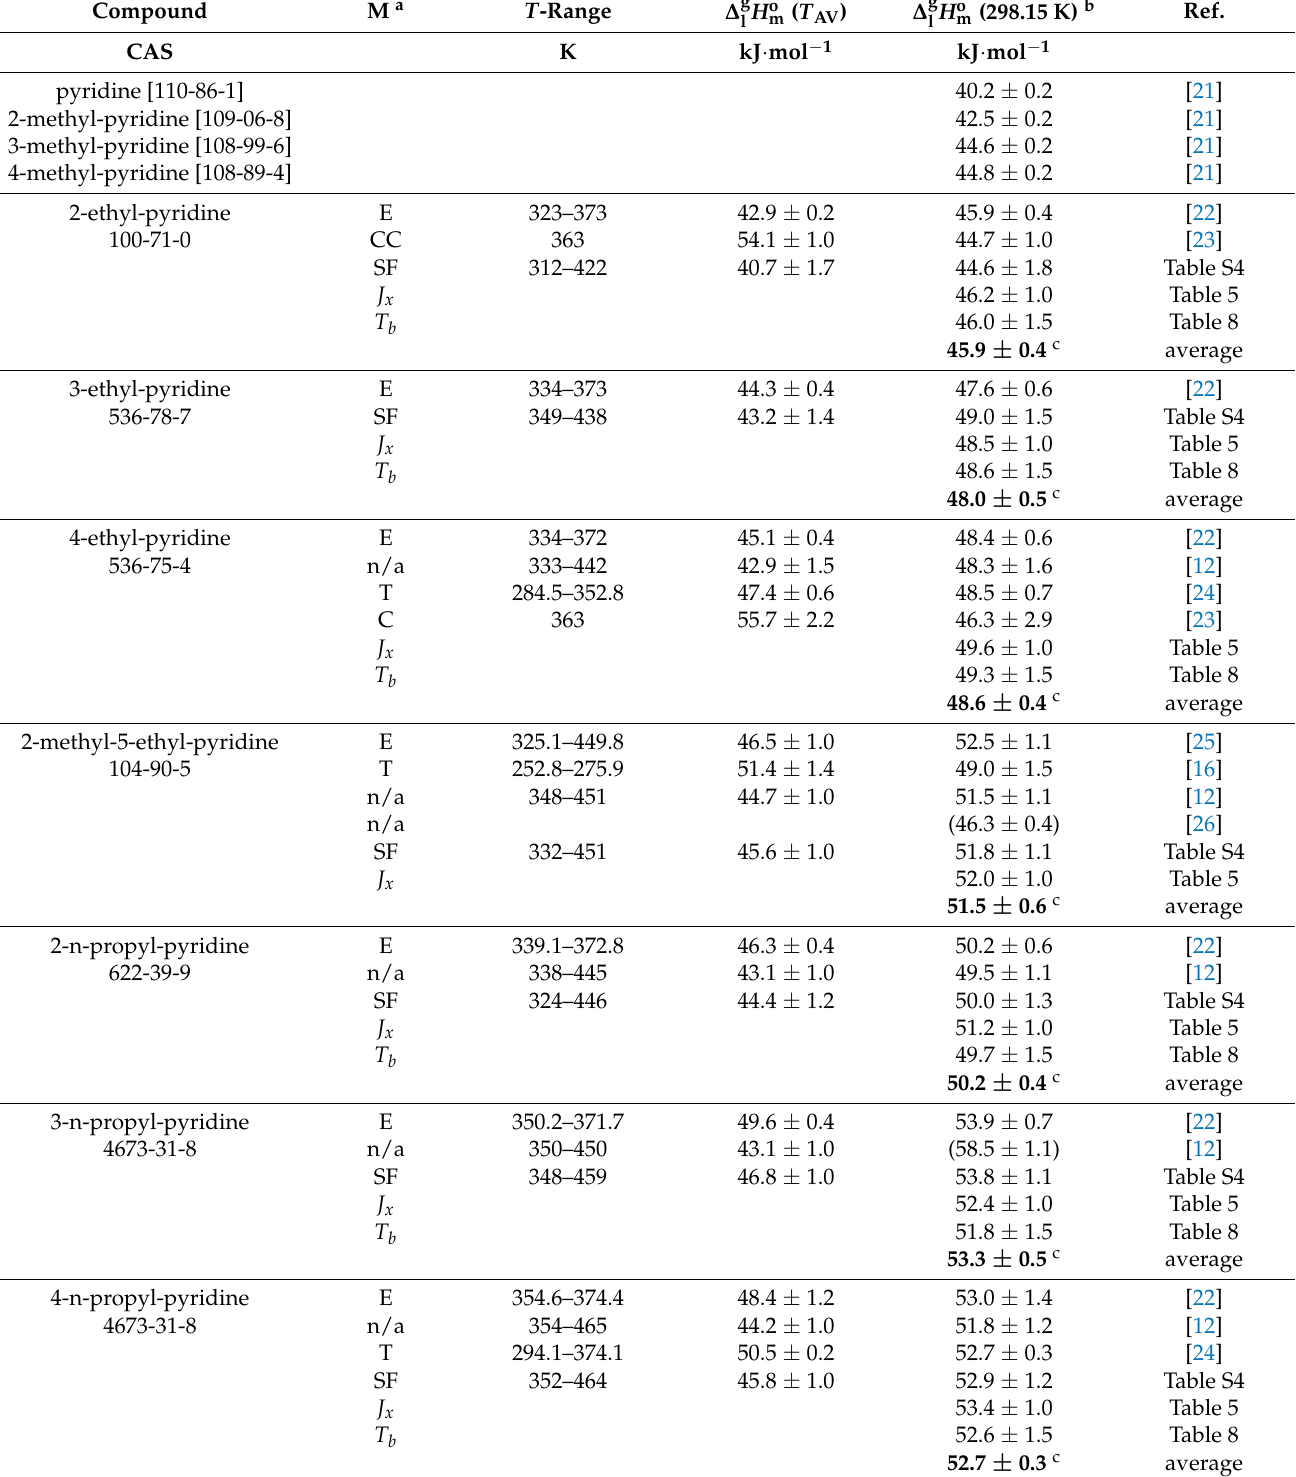
H o m , for the pyridine l